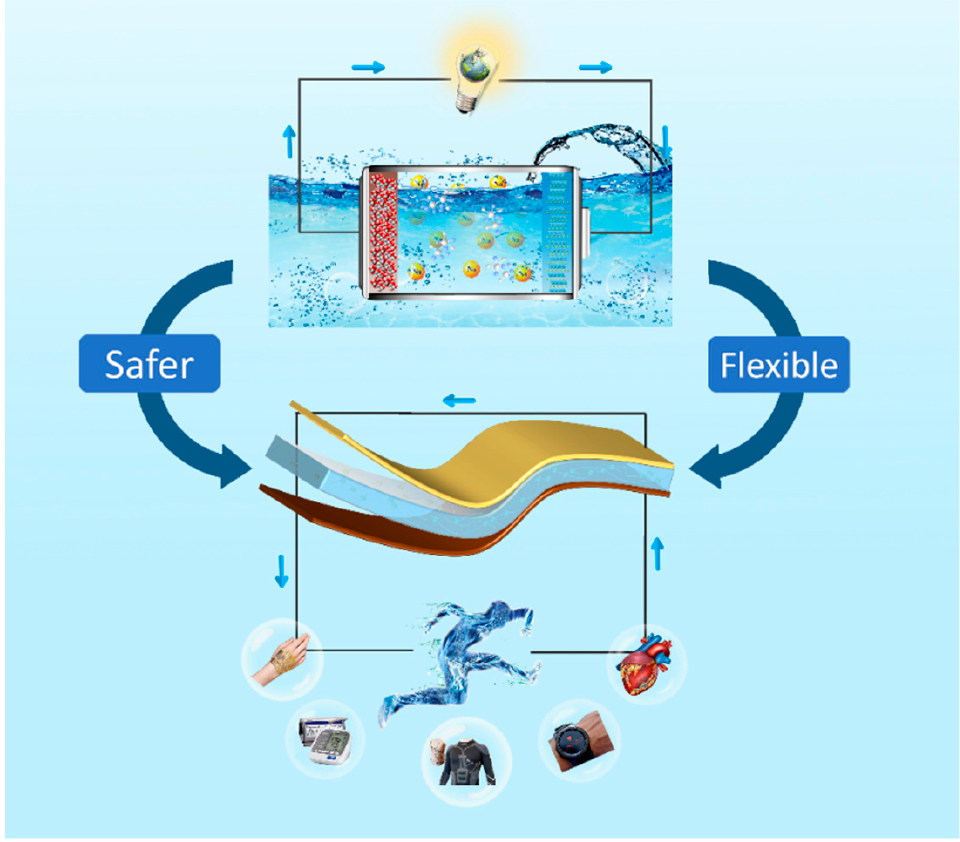
Figure 1. Schematic diagram of ASIBs from liquid to hydrogel.